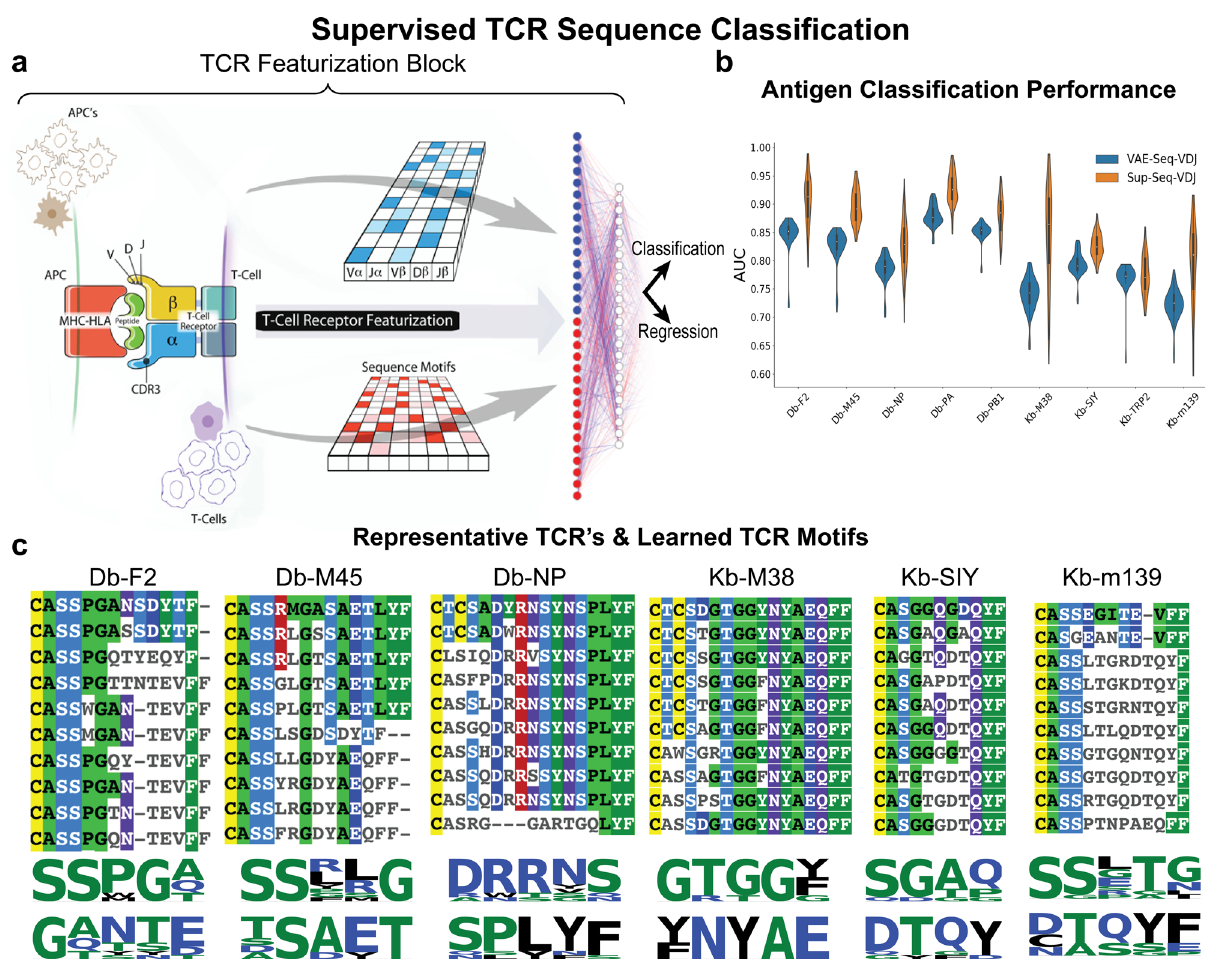
Fig. 2 Supervised TCR sequence classi fi cation. a Network architecture schema: Previously described TCR featurization block is implemented to featurize a TCR sequence and then either output a label (i.e. antigen speci fi city) or continuous regressed value (i.e. af fi nity measurement). b Supervised